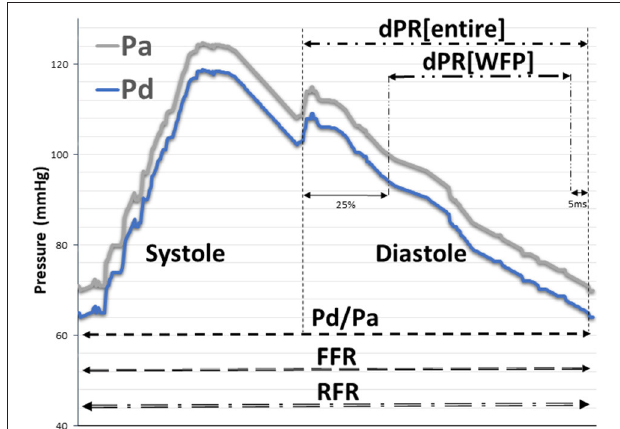
FIGURE 1 | Schematic explanation of the NHPRs and FFR. Diastole starts at the nadir of the dicrotic notch. The dPR[entire] is defined as mean Pd/Pa over the entire diastole. The dPR[WFP] is defined as the mean Pd/Pa value in the wave-free period for 5 heart cycles (from 25% of the entire diastole to 5ms before the end of diastole; equivalent to the definition of iFR). Whole cycle resting Pd/Pa was calculated continuously throughout the entire cardiac cycle for three heart cycles. FFR is defined as the lowest, artifact-free Pd/Pa during maximal hyperemia over at least three heart cycles (Pd/Pa and FFR are calculated in the same way, just under different conditions, i.e. resting conditions vs hyperemic conditions). RFR is defined as the lowest Pd/Pa value in systole and diastole (mean of 5 consecutive cardiac cycles). dPR[entire], diastolic pressure ratio during entire diastole; dPR[WFP], diastolic pressure